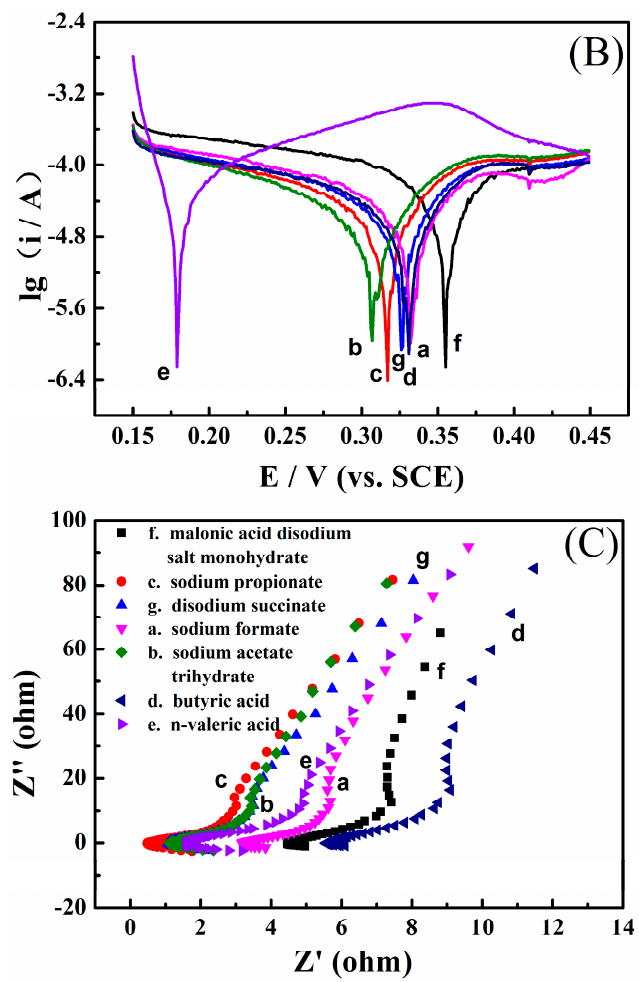
Figure 9. CV ( A ), Tafel curves ( B ), and EIS ( C ) of polyaniline in the aqueous electrolyte containing different carboxylates (a: sodium formate; b: sodium acetate; c: sodium propionate; d: sodium butyrate; e: sodium valerate; f: disodium malonate; and g: disodium succinate).